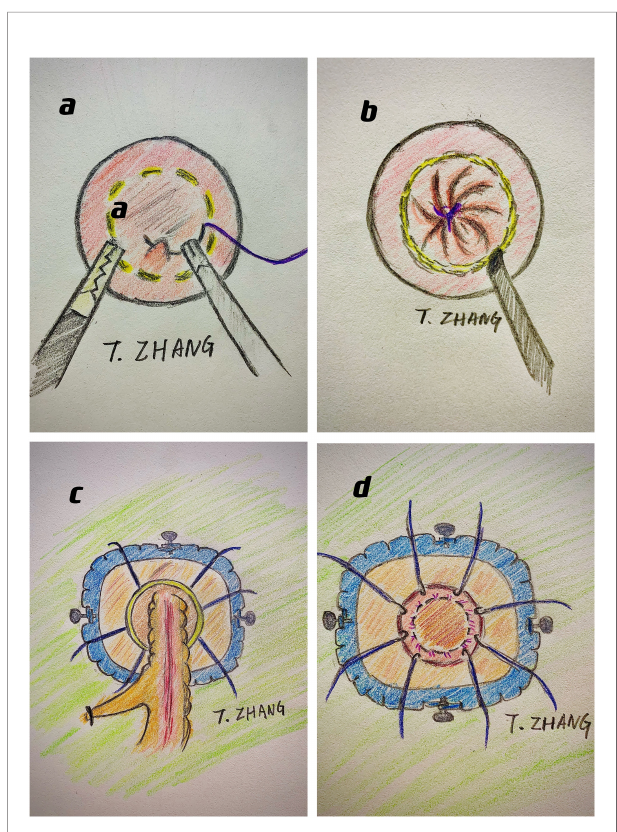
FIGURE 1 | The surgical procedures of taTME: (A) do purse-string suture at pre-marked distal margin; (B) dissect along the planned cutting line; (C) meet with the abdominal anatomy and drag out the specimen through anus; (D) anastomosis with either stapler or